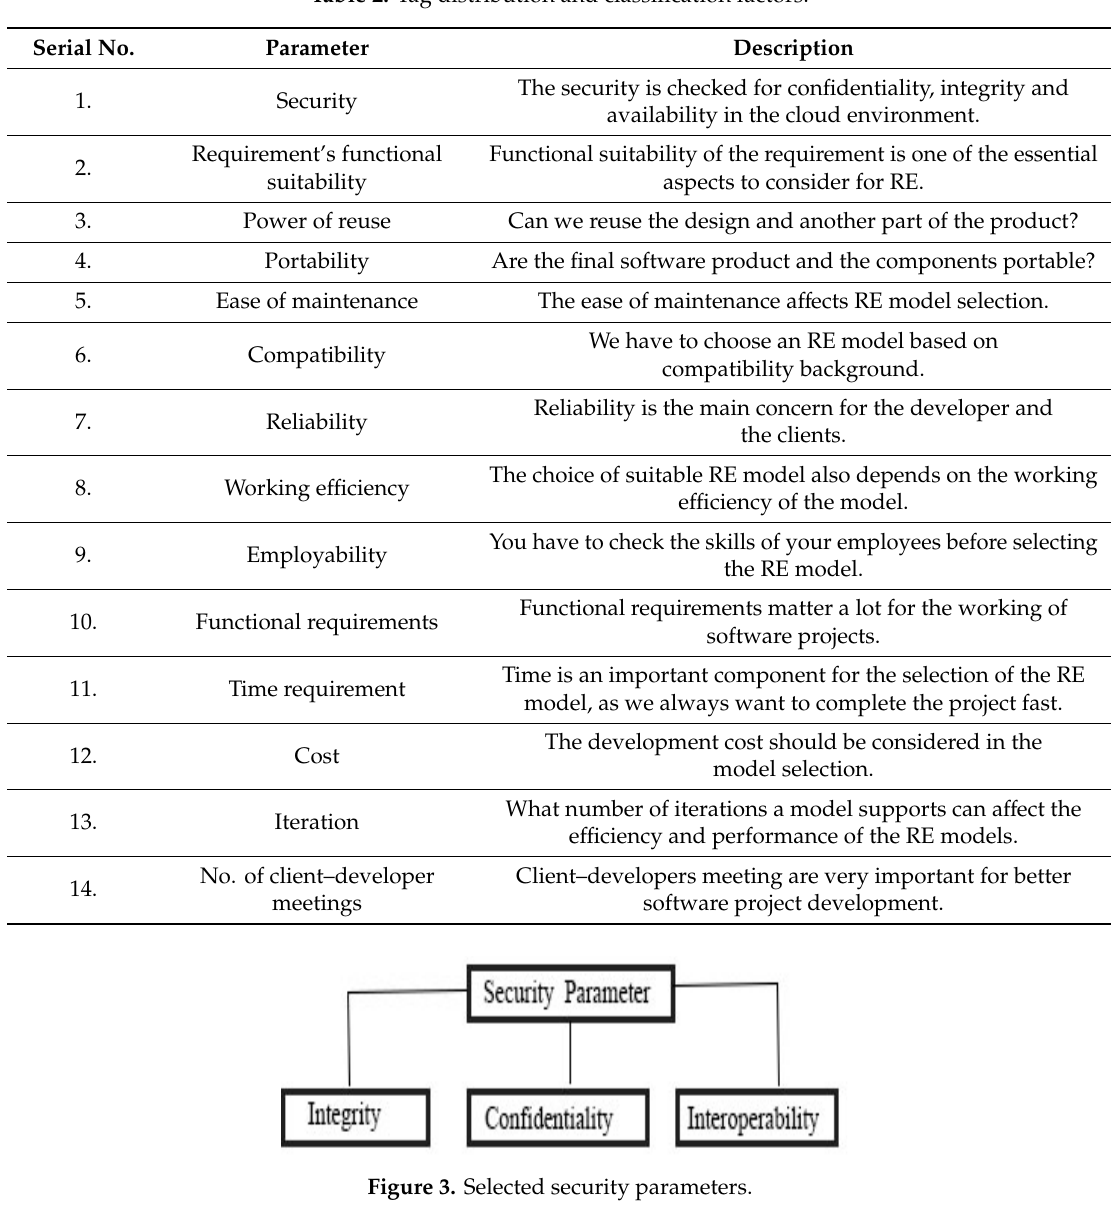
Table 2. Tag distribution and classification factors.